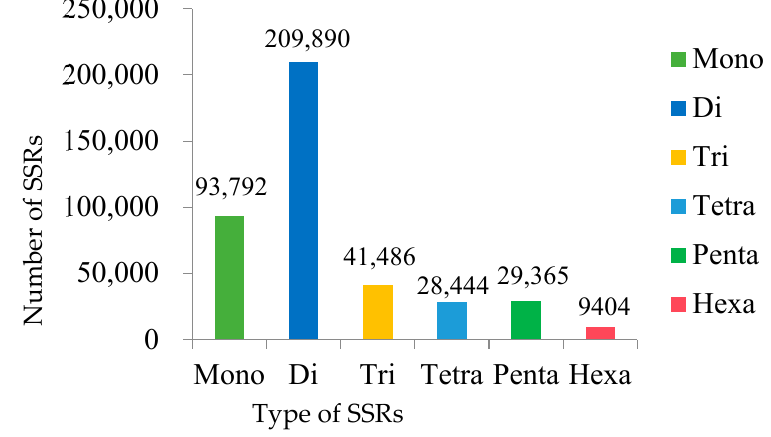
Figure 1. Distribution of SSRs in the reference genome of blackhead seabream.